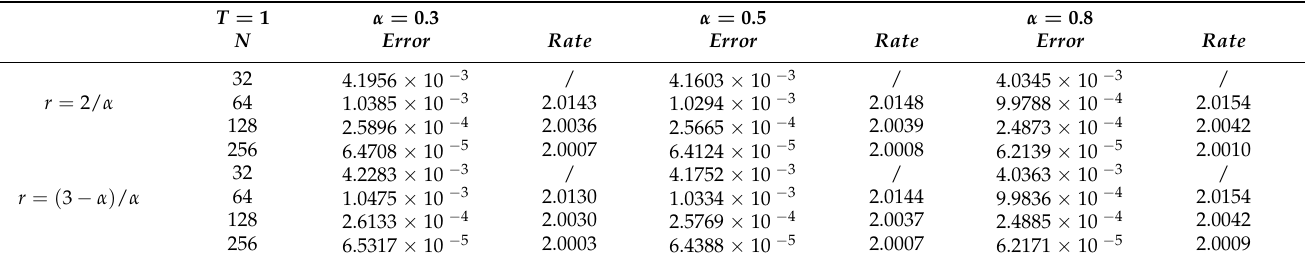
Table 3. Temporal numerical results of (cid:107) I h u n − U n (cid:107) 1 on graded meshes to Example 1.